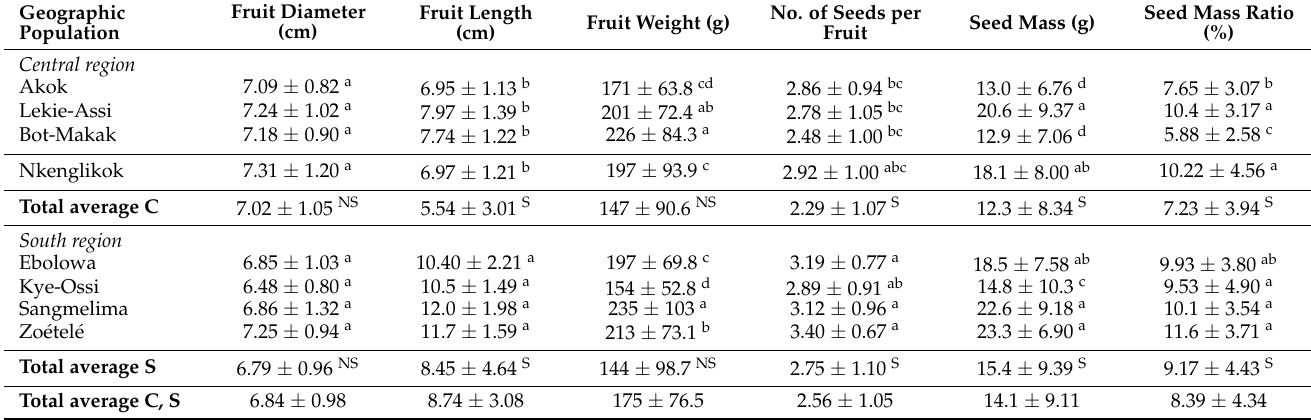
Means in each population marked with the same letter are not significantly different; S = significant difference, NS = no significant difference; the level of significance: α =